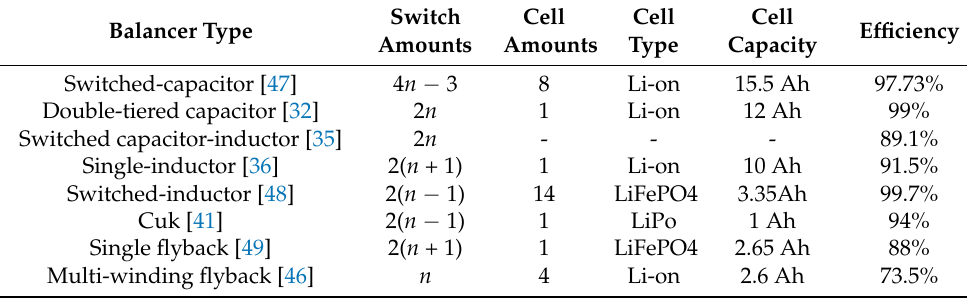
Table 2. Comparison of the CC–CC converters for active